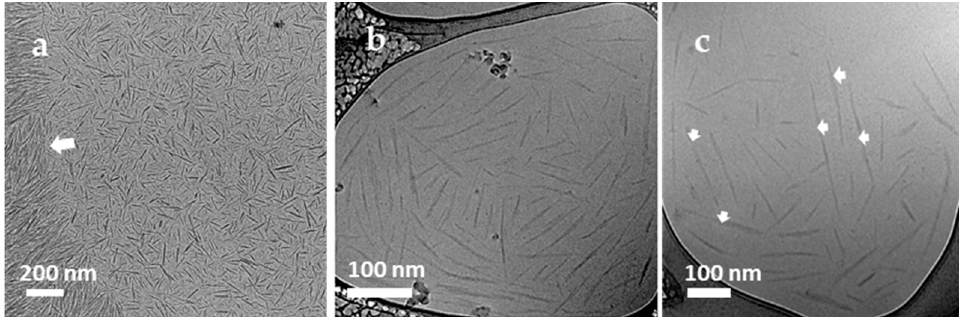
Figure 5. ( a ) coffee-ring formed while unstained CNCs dried on carbon film and more CNCs are concentrated on the edge (white arrow) with well-dispersed CNCs in the center; ( b ) cryo-TEM im- ages of CNCs embedded in vitreous ice taken from the areas near the rim of TEM grids; CNCs lined up parallel to the hole edge and filled across the hole; and ( c ) less ordered CNCs embedded in the ice near the hole edge taken from near the center of TEM grids; possible end-to-end or slightly side-by-side arranged CNCs are pointed by arrows.